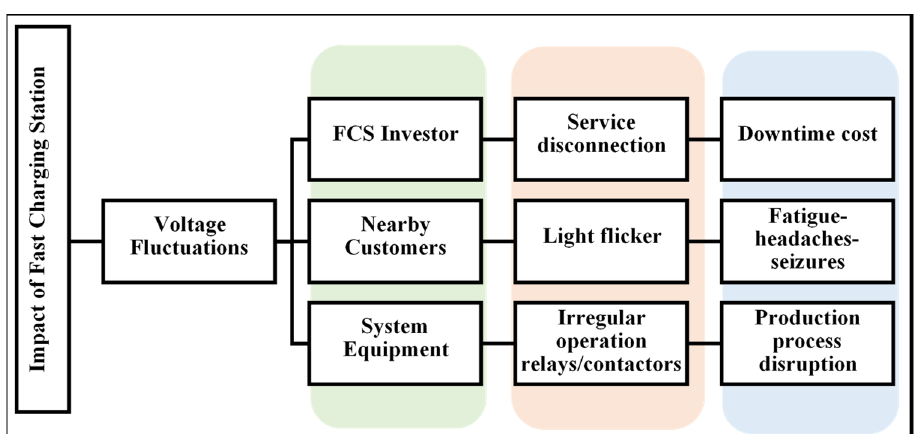
Figure 1. Effect of voltage fluctuation on different stakeholders.